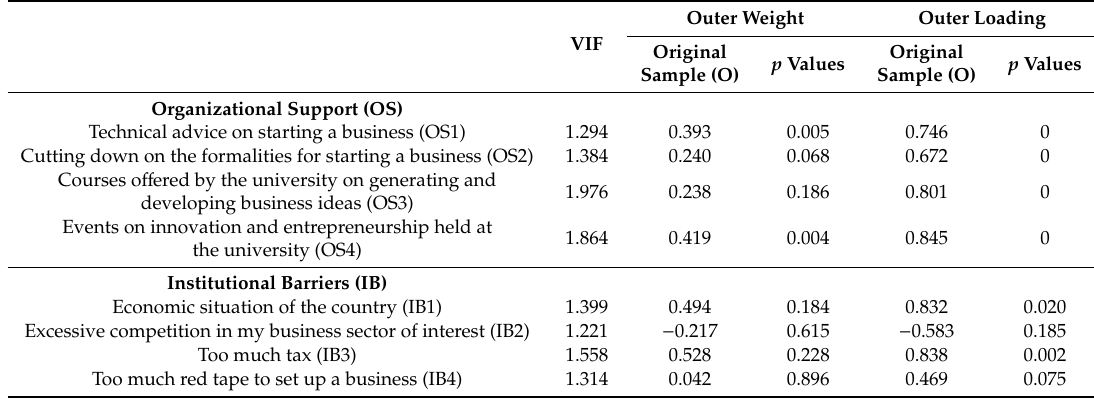
Table 6. Assessment of the measurement model: formative